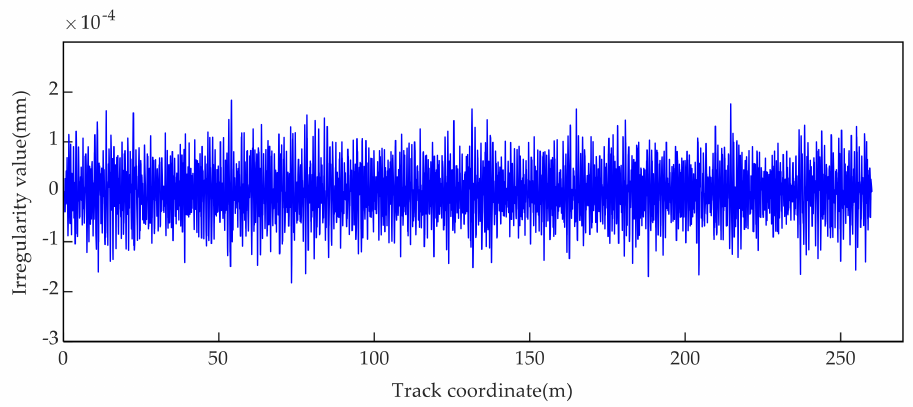
Figure 6. Sample of the short wave random